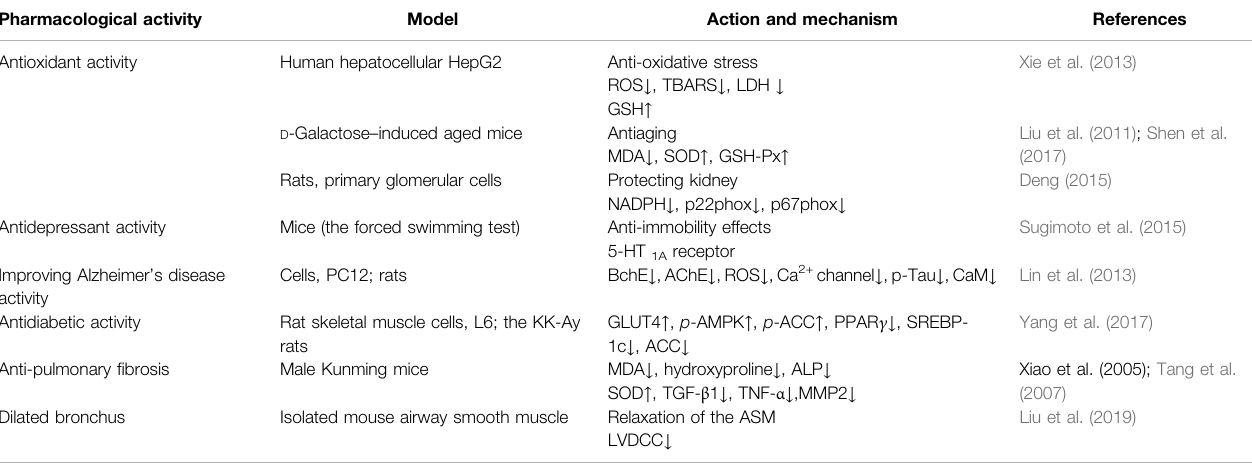
TABLE 1 | Pharmacological activities of